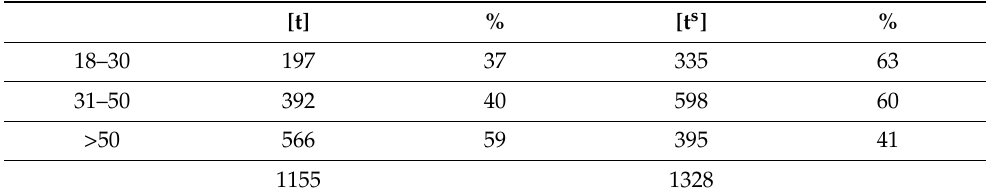
Table 4. Age distribution of dental